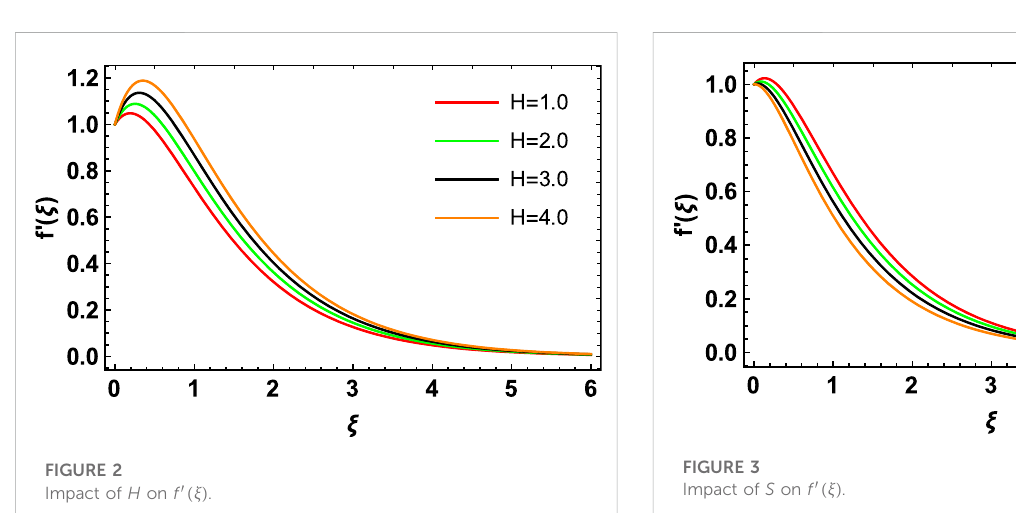
FIGURE 3 Impact of S on f ′ ( ξ ) .